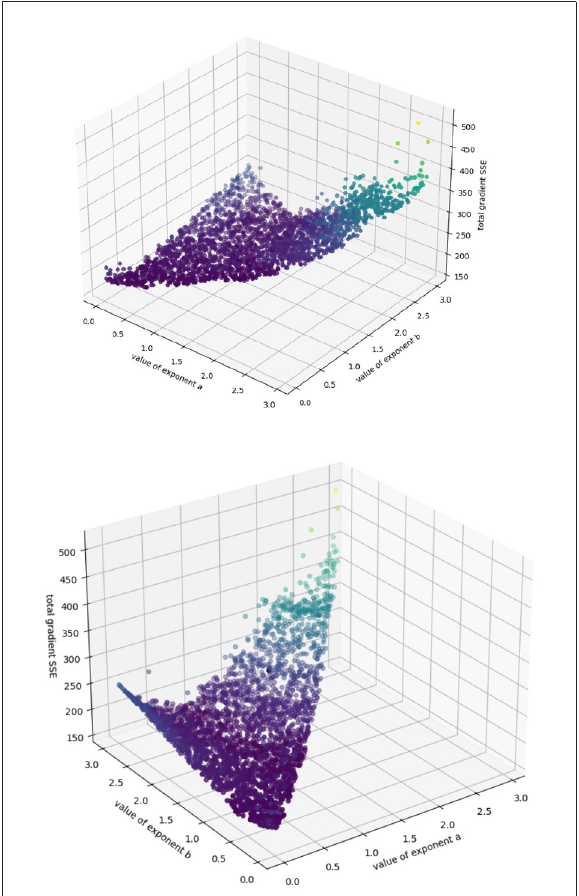
FIGURE2 Sum of squared error from extrapolation from fitted (p, q) values for each exponent-pair value; color simply corresponds to height for highlighting